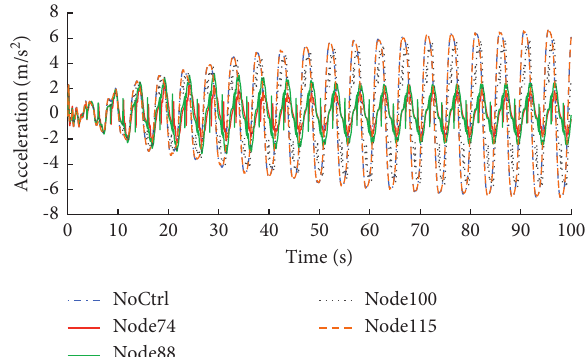
Figure 17: : Time history of the acceleration of the SCR imple- mented with PTMD installed at different